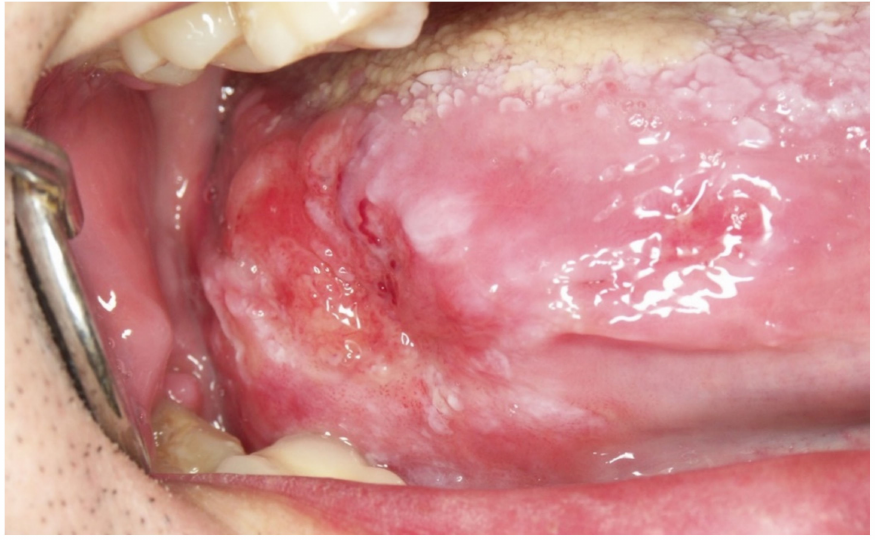
Figure 9. Advanced tumour growing silently on the lateral border of the